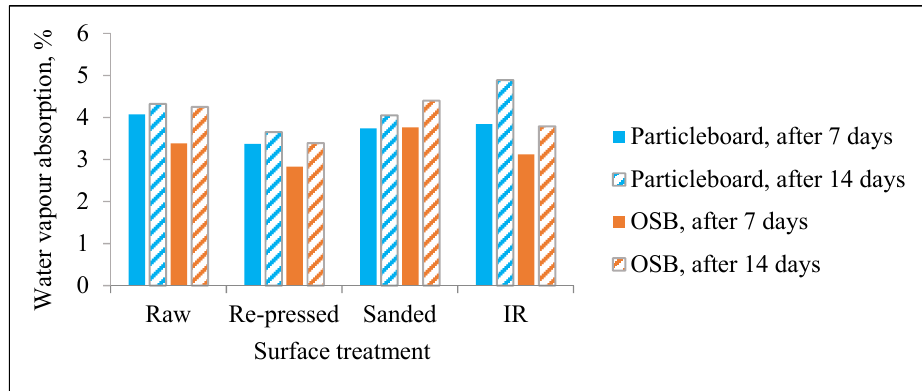
Figure 5. Water vapour absorption of tested particleboard and OSB panels after 7 and 14 days of exposure to high humidity. No statistically significant difference was found between surface treatments and raw panels.